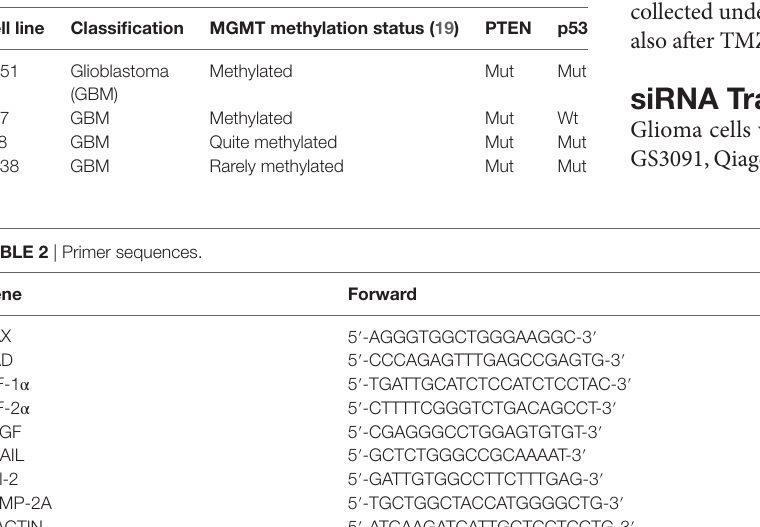
TaBle 1 | Glioma cell genetic